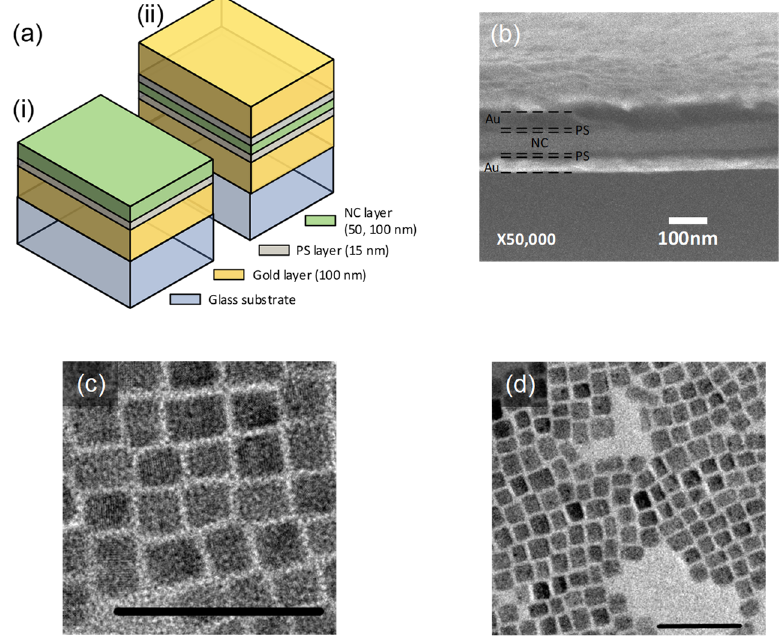
Figure 1. ( a ) Schematic of (i) single- and (ii) double-Au-PS layers with CsPbBr 3 or FAPbBr 3 NCs; ( b ) Scanning electron micrograph of the cross section of 50 nm CsPbBr 3 NCs, double 15 nm PS films, and double-Au layers; TEM pictures of ( c ) CsPbBr 3 and ( d ) FAPbBr 3 NCs, with black scale bar indicating 50 nm.